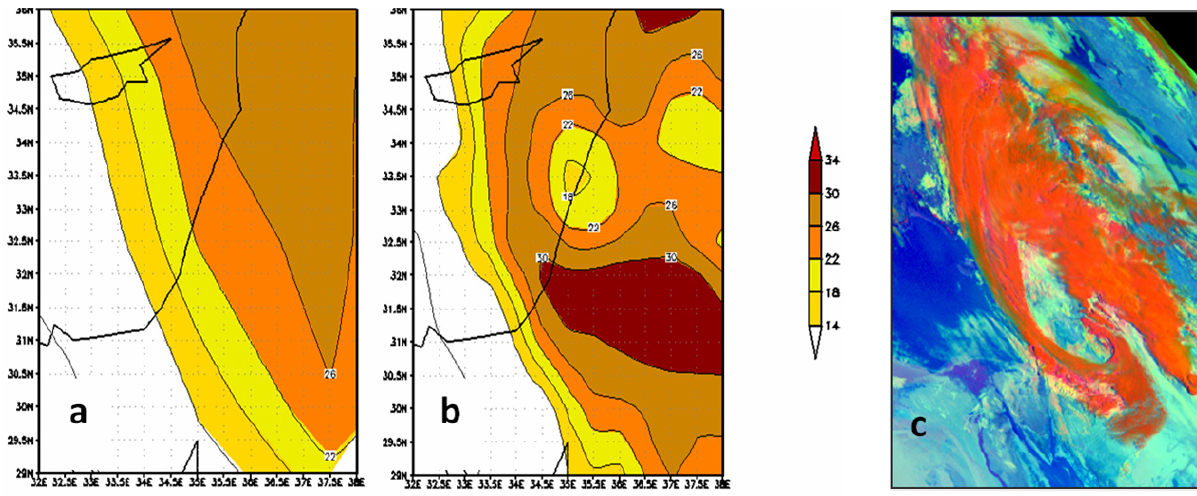
Fig. 1. Spatial distribution of MKI for 2 April 2006, 06:00UTC, based on (a) NCEP/NCAR with 2.5 ◦ × 2.5 ◦ resolution and (b) ECMWF with 0.5 ◦ × 0.5 ◦ resolution. (c) Concurrent MSG imagery for the same time, showing the street of clouds (red) that produced the rain.